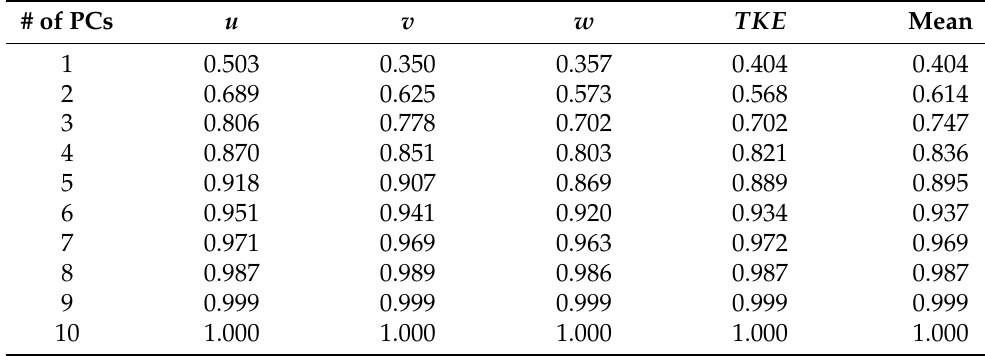
Table 1. Cumulative sum of explained variance ratios, calculated for the specified amount of principal components extracted via distinct PCAs of the original data’s